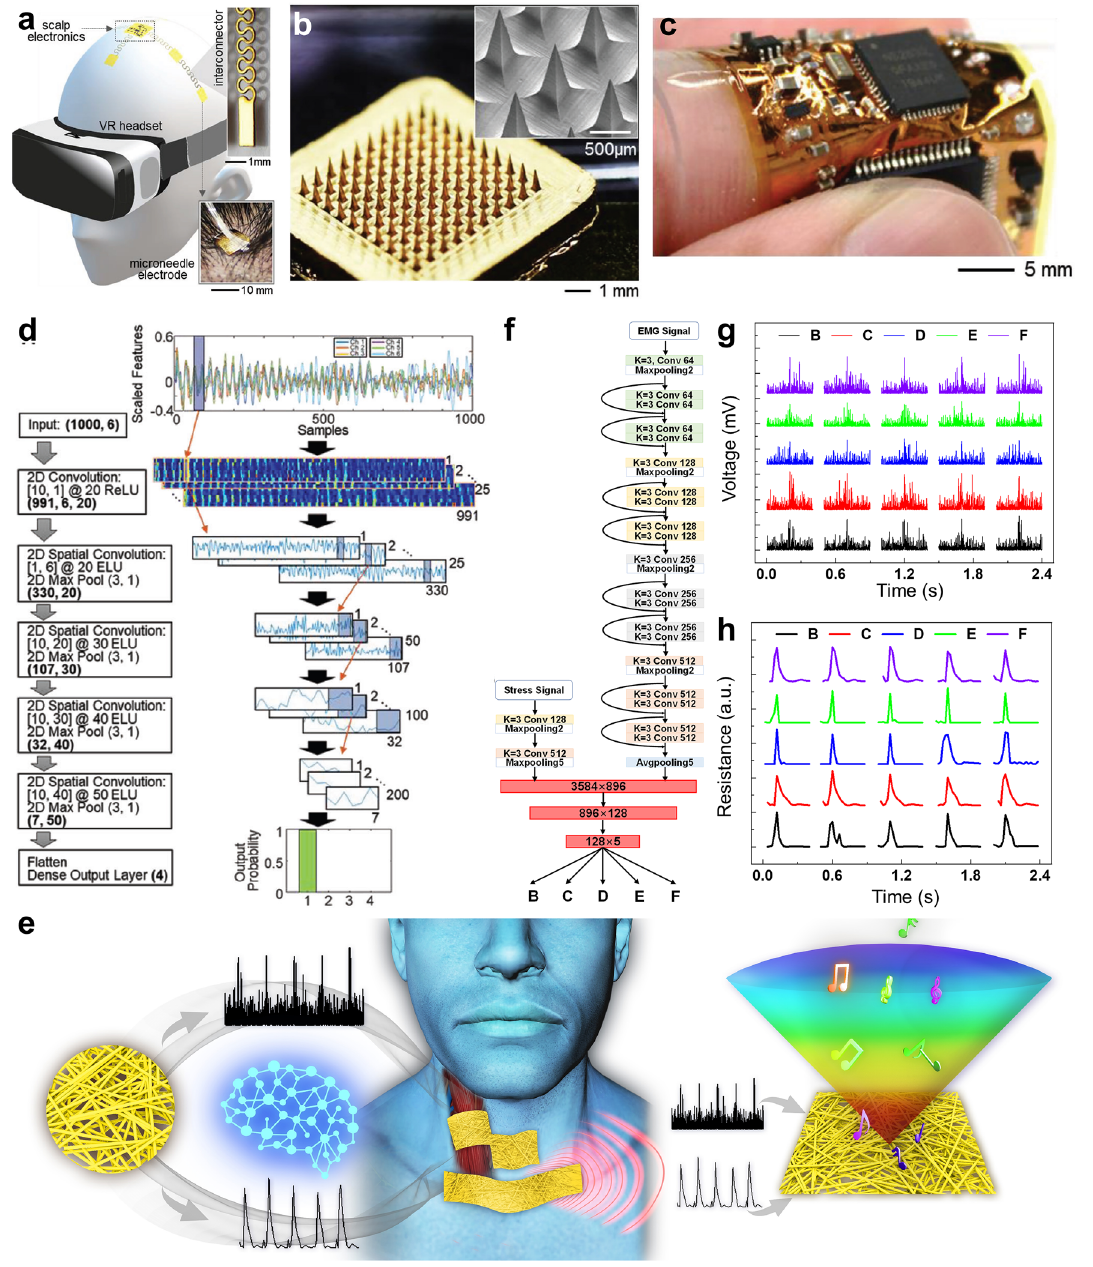
Fig. 28 CNN for classification task. a Illustration of a tester wearing VR headset and scalp electronics with stretchable interconnectors and a soft microneedle electrode. b Zoomed-in photograph of a microneedle array along with a magnified SEM image (inset). c Photograph of a soft wireless circuit with integrated chips, which has mechanical compliance. d Detailed illustration of a spatial CNN model with hidden layers of brain signals acquired from six EEG channels, which demonstrates the capability of decomposing spatial features. Reproduced with permission [343]. Copyright (2021), Wiley–VCH. e Diagram of the intelligent nanomesh artificial throat, including nanomesh voice detecting part (strain sensor and EMG electrodes), electromyogram-strain synergetic CNN algorithm, and nanomesh sound source. f Diagram of the CNN algorithm consisting of modified 1D ResNet18 (EMG part) and common two-layer CNN (strain part). g Typical EMG signals detected by the Au nano- mesh electrodes when tester spoke “B”, “C”, “D”, “E”, and “F”. h Typical normalized strain signals detected by the Au/PU nanomesh strain sen- sor when tester spoke “B”, “C”, “D”, “E”, and “F”. Reproduced with permission [182]. Copyright (2022),